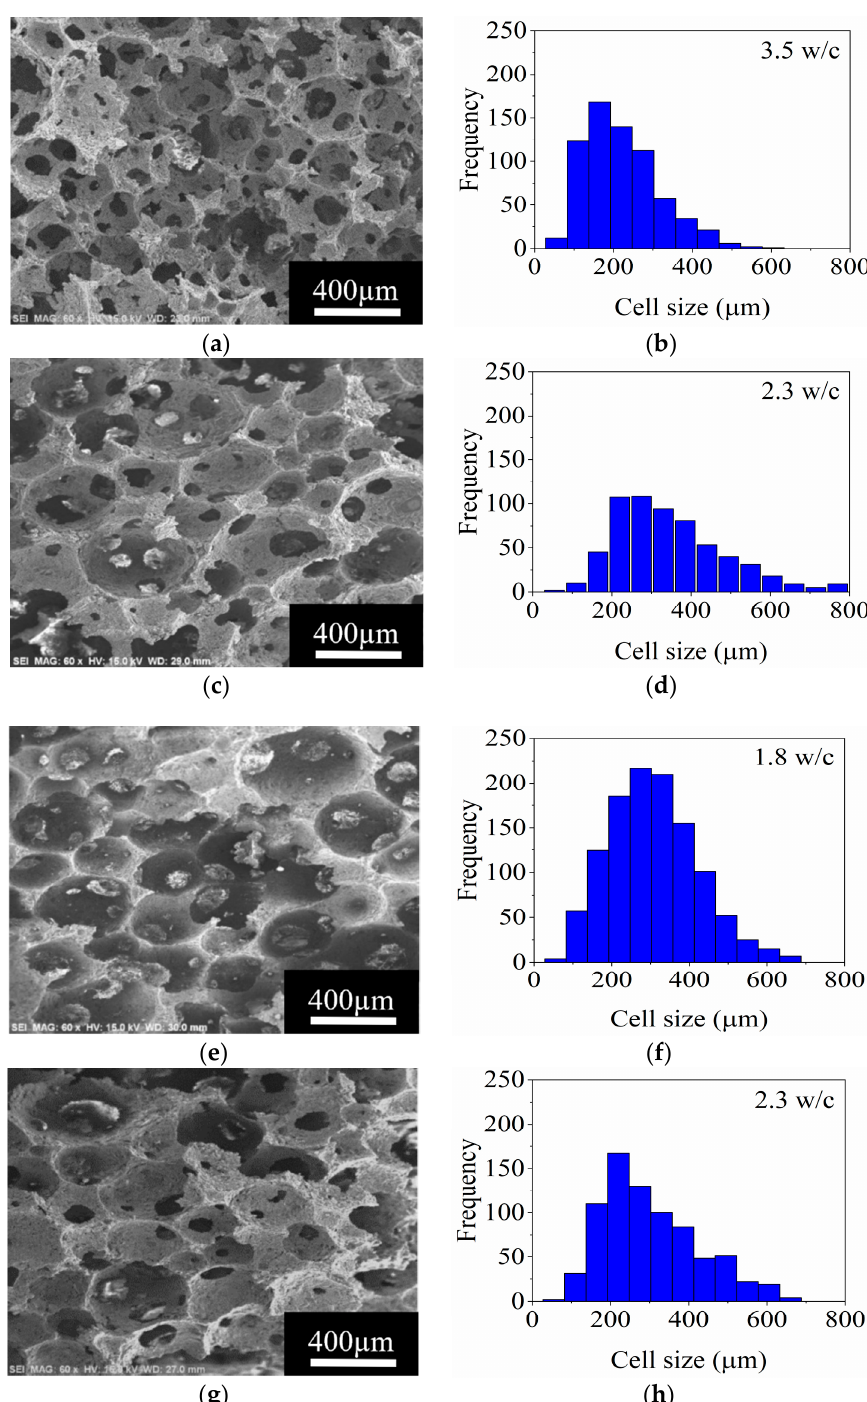
Figure 10. SEM micrographs and frequency histograms of the cell size obtained using the 4-arm anchor impeller at different stirring rates: ( a ) and ( b ), 1070 rpm; ( c ) and ( d ), 1194 rpm; ( e ) and ( f ), 1240 rpm; and ( g ) and ( h ), 1283 rpm, respectively.